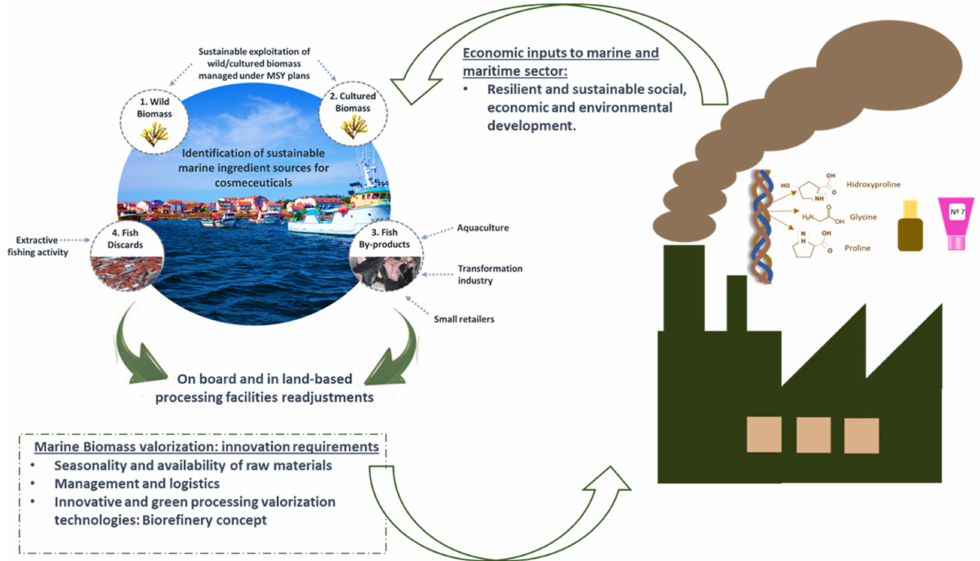
Figure 2. Sustainable production of marine cosmeceutical